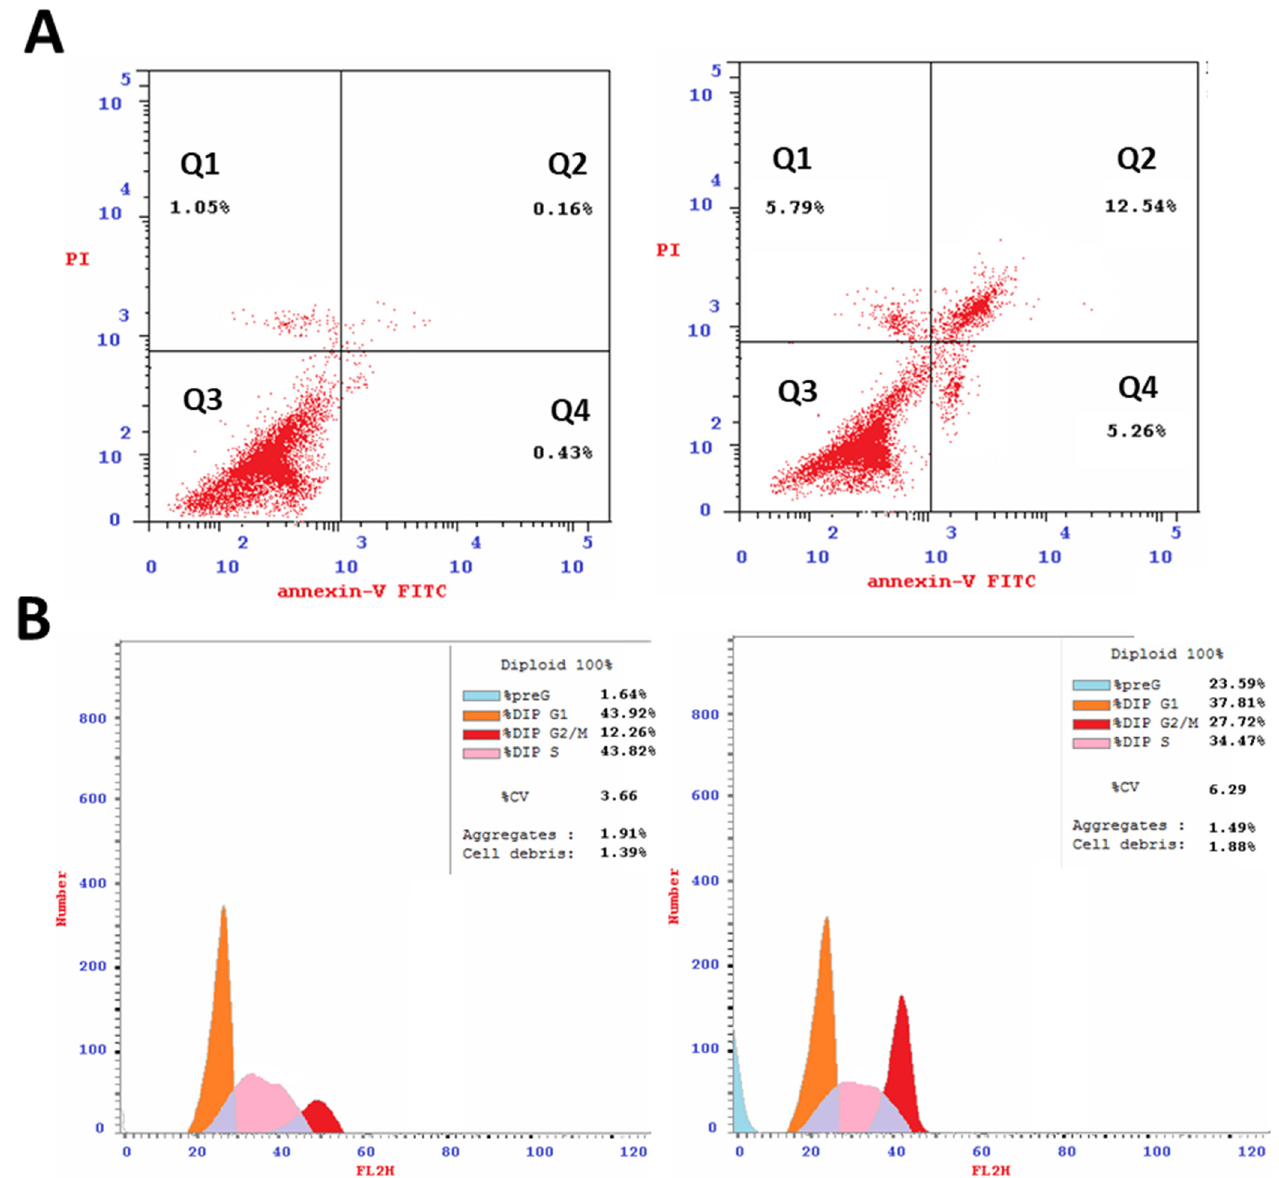
Figure 2. ( A ): FITC/annexin-V-FITC/PI differential apoptosis/necrosis of untreated and treated A549 cells with A. judaica L. ethanolic extract (IC 50 of 14.07 μ g/mL, 48 h). Quadrant charts show Q-1 (necrosis, AV–/PI+), Q-2 (late apoptotic cells, AV+/PI+), Q-3 (normal cells, AV–/PI–), and Q-4 (early apoptotic cells, AV+/PI–). ( B ): Cell cycle analysis of untreated and treated A549 cells.